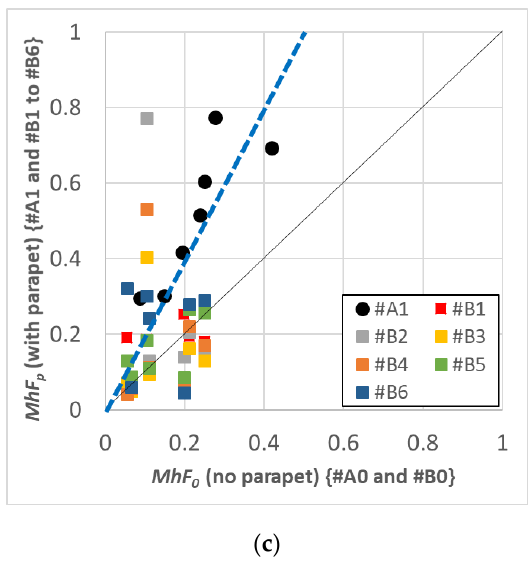
Figure 11. Comparison of ( a ) Fh 0 and Fh p , ( b ) FvF 0 and FvF p , and ( c ) MhF 0 and MhF p .